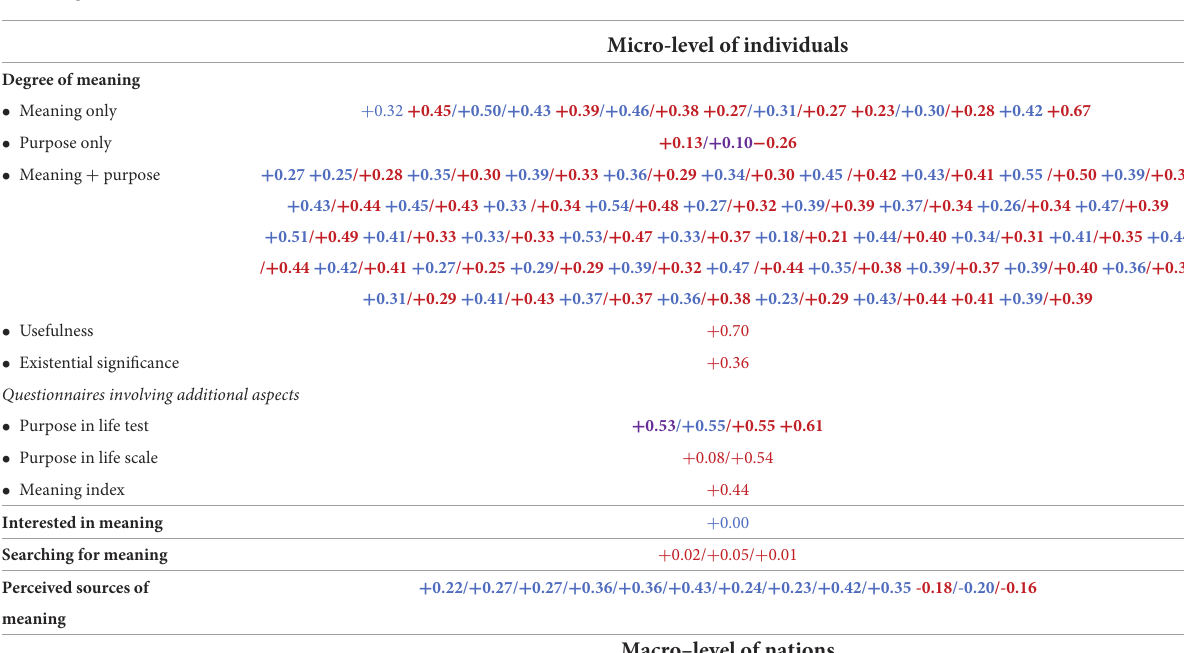
TABLE 5 136 findings on strengths of correlation between perceived meaning of life and satisfaction with life distinguishing between overall life satisfaction, hedonic level of affect, and contentment. Aspects of perceived Observed correlation with happiness in cross-sectional studies expressed in Pearson correlation meaning in life Micro-level of